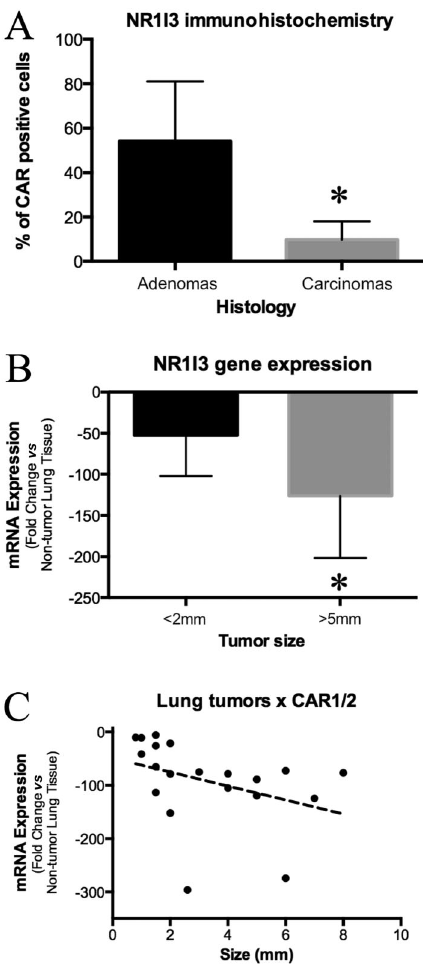
Figure 2. Detection of NR1I3 in lung tumors induced by 4- (methylnitrosamino)-4-(3-pyridyl)-1-butanone (NNK) in mice. A : Immunohistochemical detection of NR1I3 in lung adenomas and carcinomas. Note that carcinomas showed significantly less NR1I3 expression than did adenomas. B : NR1I3 mRNA expres- sion showed an inverse correlation with tumor size. C : NR1I3 mRNA expression compared between lesions , 2 mm and lesions . 5 mm. Tumors . 5 mm are all carcinomas and lesions , 2 mm are all adenomas (Ref. 9). Note that lesions . 5 mm expressed significantly less NR1I3 mRNA than did lesions , 2 mm. *P , 0.05 (unpaired t